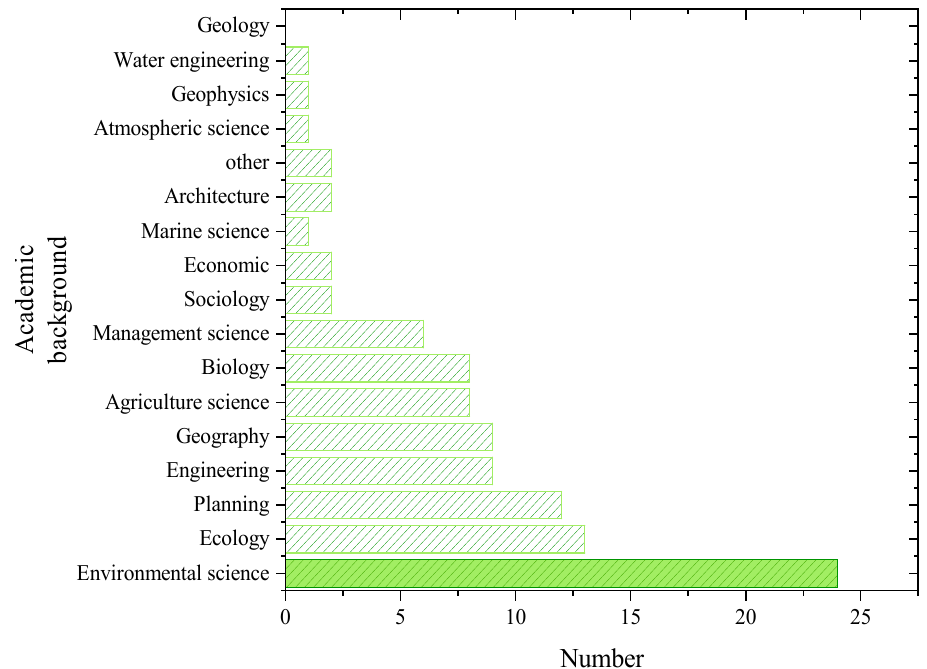
Figure 4. The research background of the authors of the selected articles.